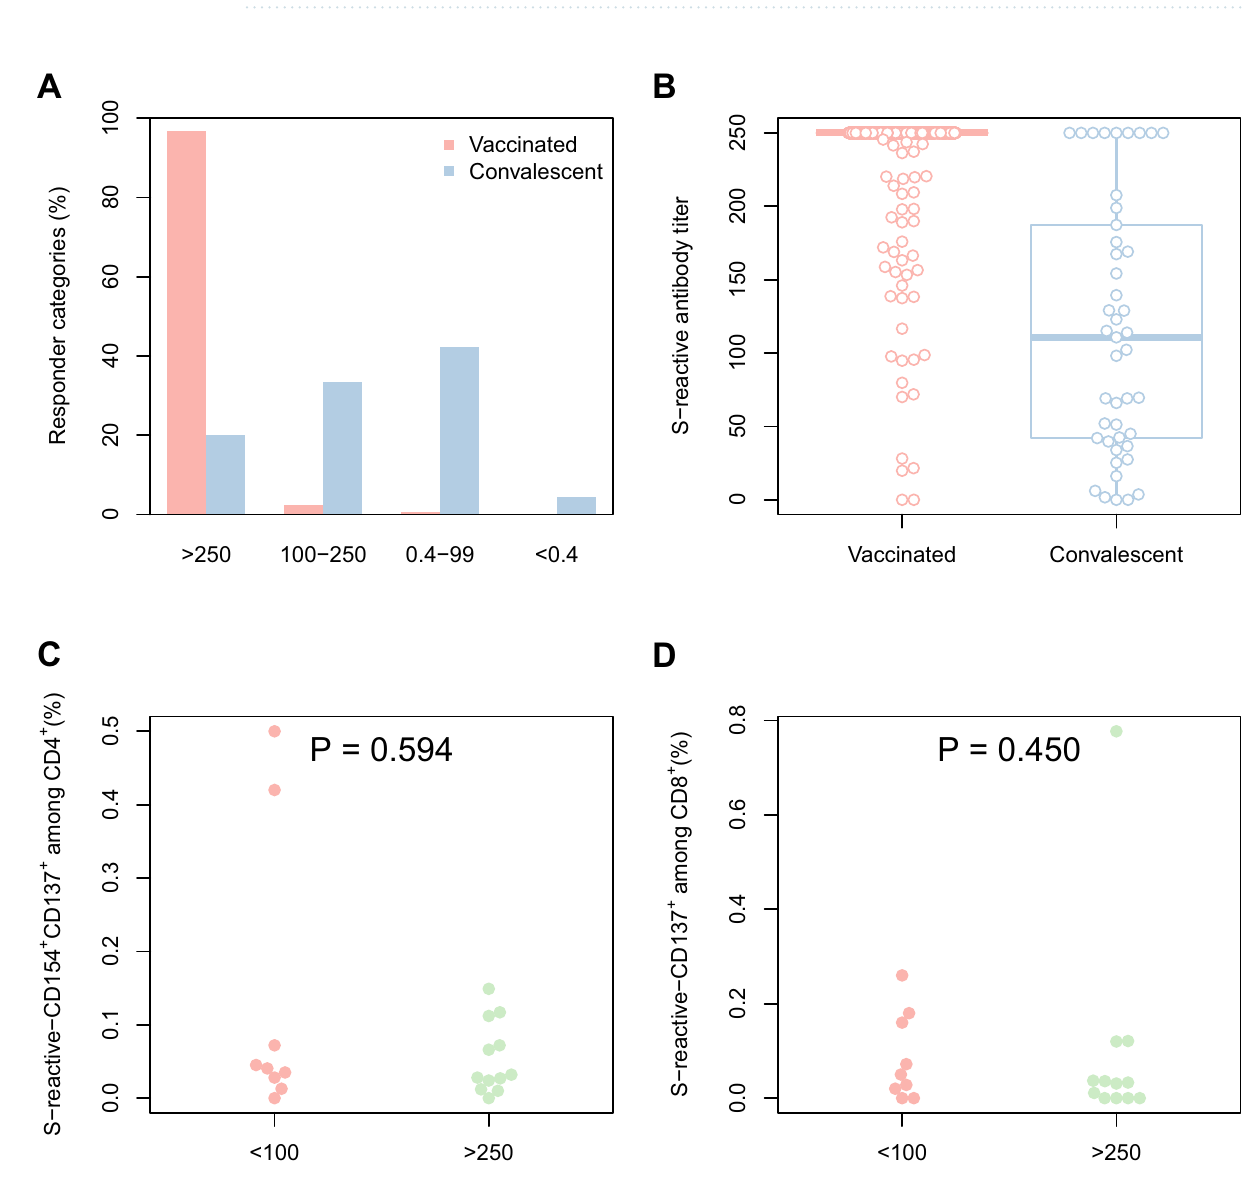
Table 1. Epidemiology and SARS-CoV-2 reactive humoral immune response in healthcare workers after vaccination or prior COVID-19. Data of vaccinated vs. convalescent healthcare workers were compared using Mann–Whitney test in case of continuous data, and by Fisher’s exact test in case of dichothomic data. Differences in assignment to one of the antibody concentration strata was analyzed by Chi-squared test.